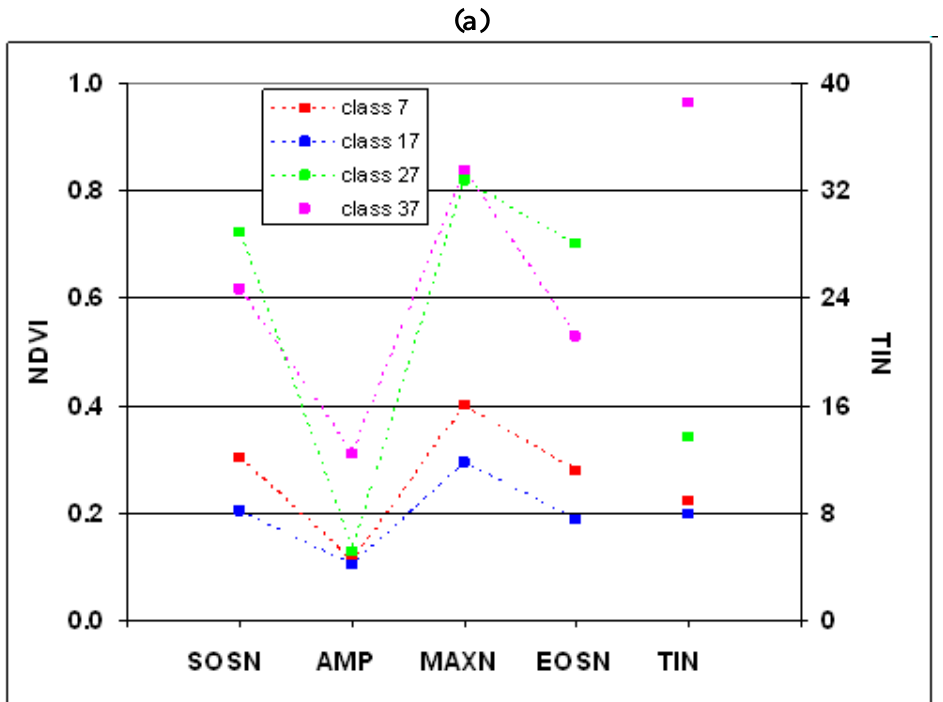
Figure 3. Mean values of nine phenological metrics and the DEM data for representative pheno-classes 7, 17, 27, and 37. The nine phenological metrics included start-of-season time (SOST), start-of-season NDVI (SOSN), end-of-season time (EOST), end-of-season NDVI (EOSN), maximum NDVI (MAXN), maximum NDVI time (MAXT), duration of season (DUR), amplitude of NDVI (AMP), and seasonal time integrated NDVI (TIN). (a) NDVI-based phenological metrics; (b) timing-based phenological metrics and